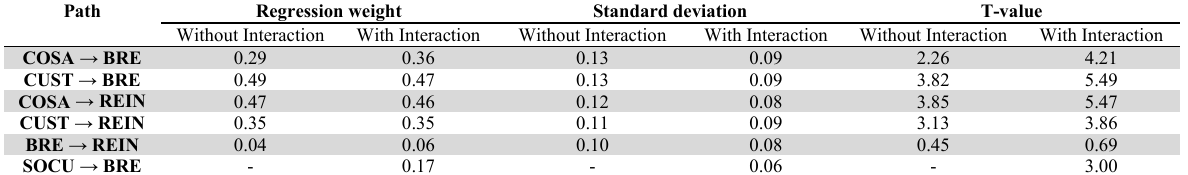
Comparison of regression weight, standard deviation, and t-value between models without interaction and models with inter- actions in direct